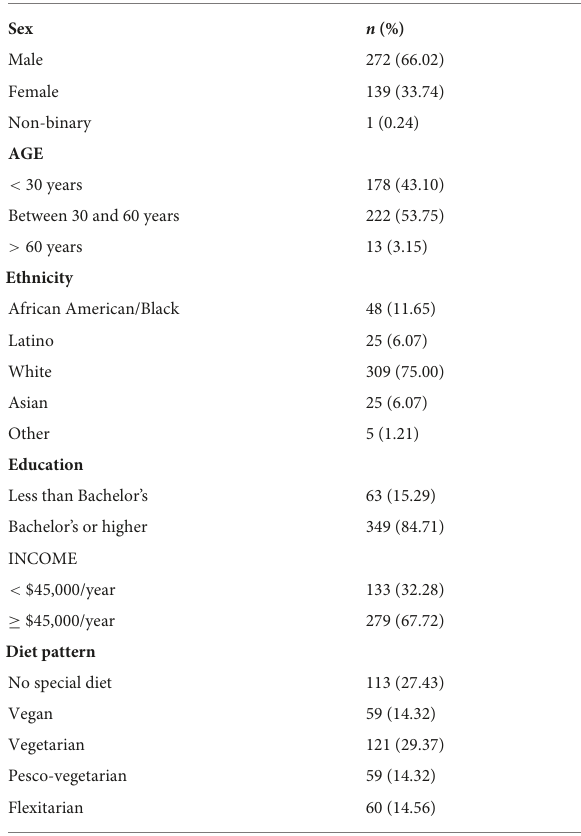
TABLE 1 Demographic characteristics of the WFPBD survey